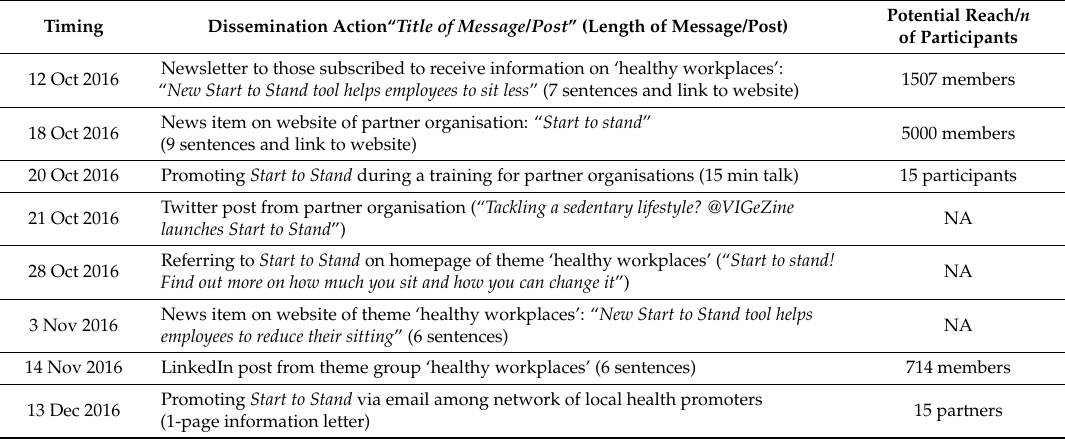
Table 1. Dissemination actions undertaken by the Flemish Institute Healthy Living to promote Start to Stand